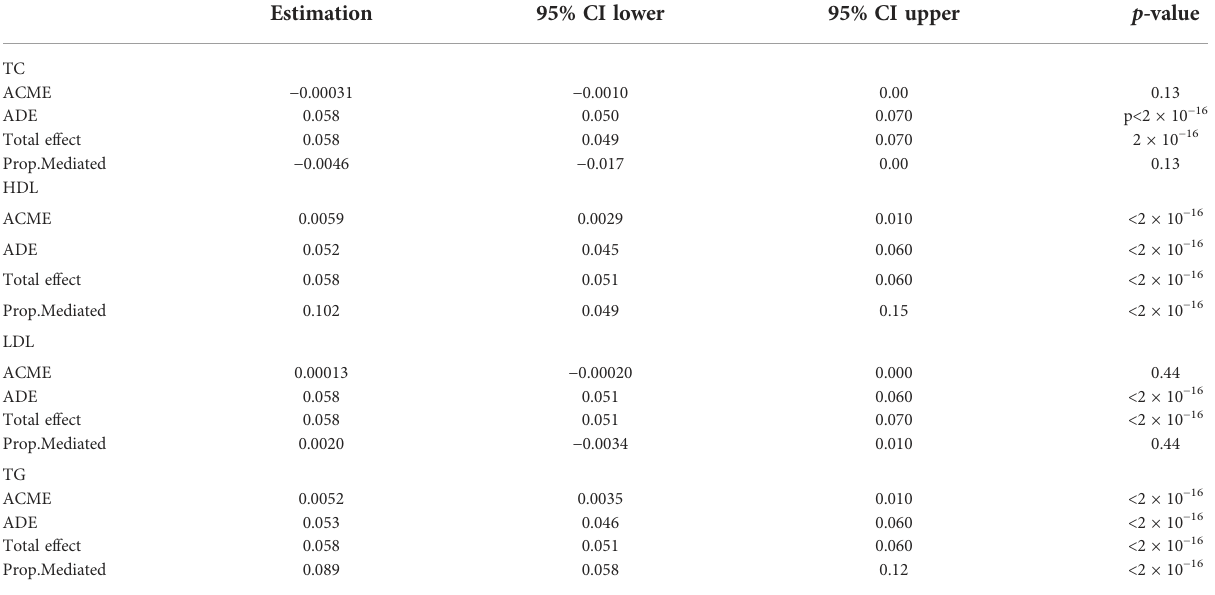
TABLE 2 The results of observational mediation analysis. Estimation